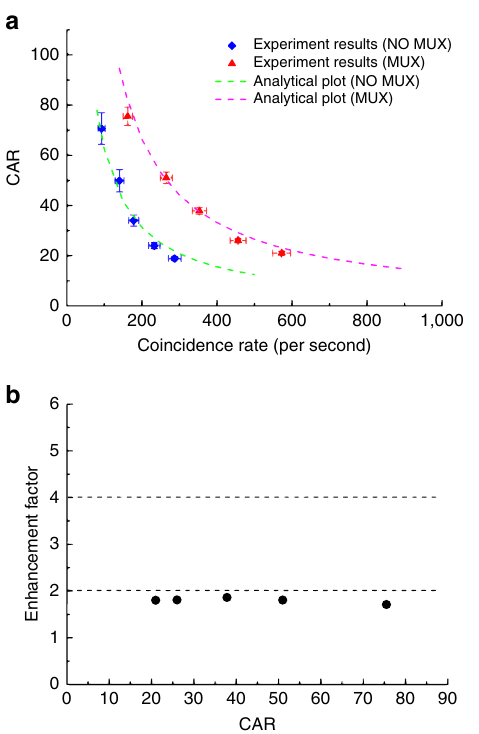
Figure 3 | Comparison between sources with and without multiplexing. ( a ) CAR as a function of coincidence rates. Poisson error bars are used for the plots. Dashed lines are analytic plots using the model in ref. 25. ( b ) The inferred enhancement factors to the heralded single-photon output probability at each CAR level.